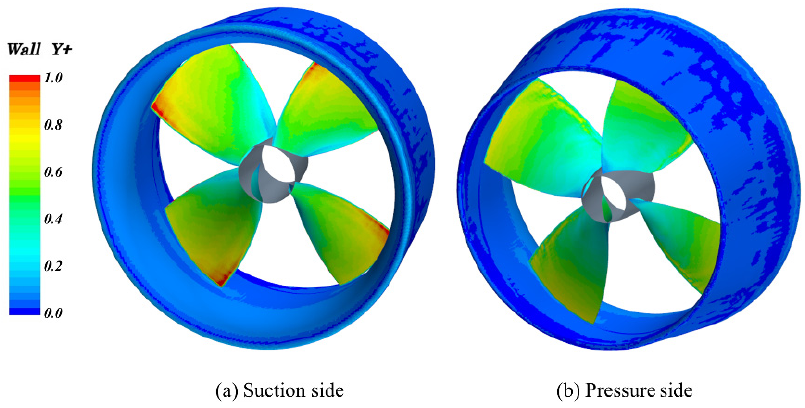
Figure 9. Wall y+ of the ducted propeller when J = 0.6.